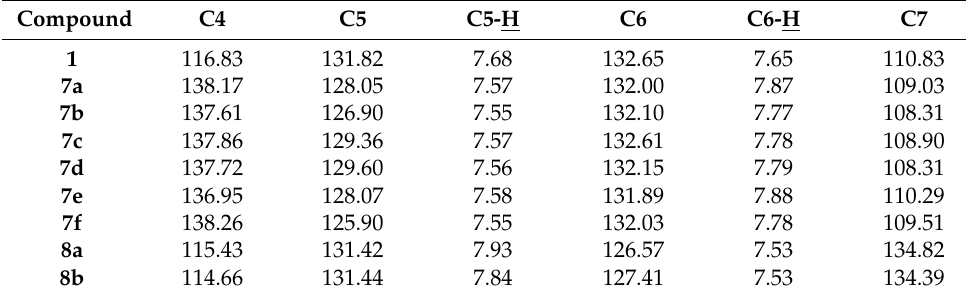
Table 4. Key 1 H and 13 C signals in the spectra of compounds 1 , 7 and 8